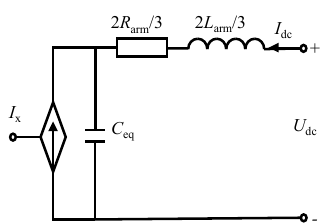
Figure 9. DC side modified AVM of the